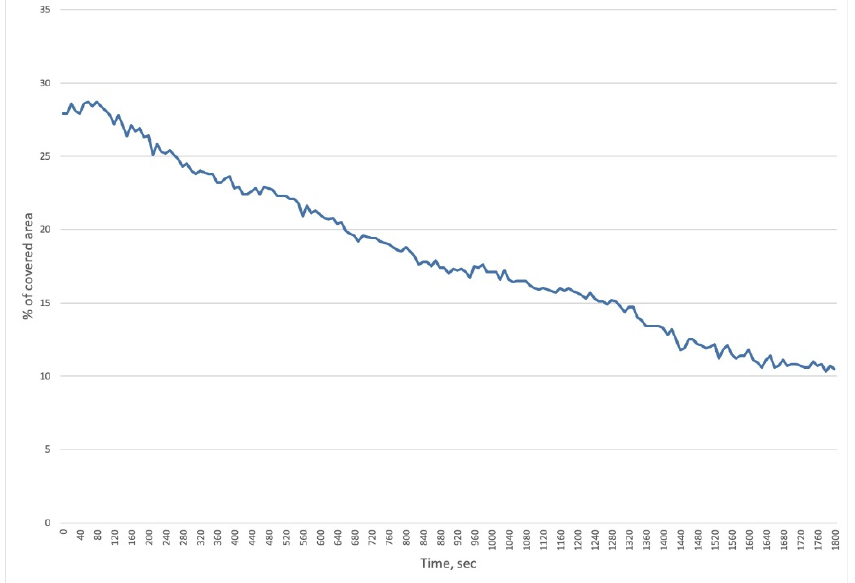
Figure 3. Reduction in bacterial coverage of the area observed with the 3D Cell Explorer microscope within 30 min (after 2 h 30 min from the addition of bacteriophage cocktail to the Kl 315 culture). The experiment was conducted in one repetition.